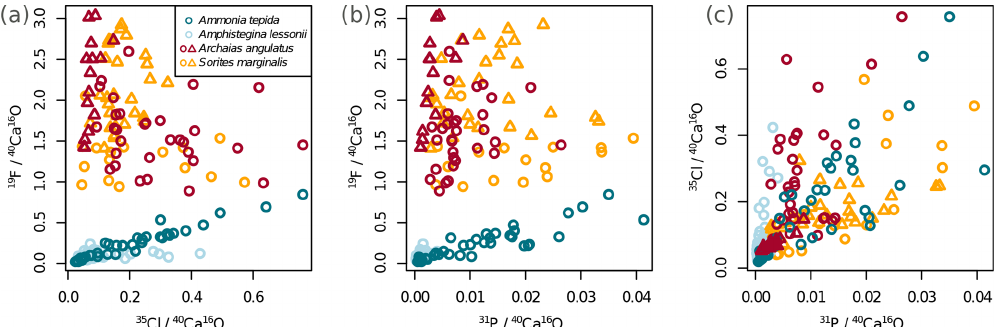
Figure 2. Variability of the different El / Ca ratios within shells of the studied foraminifera. Individual data points represent multiple regions of interest (ROIs) drawn on the images as described in Sect. 2.4. Values are shown as ratios of secondary ion counts measured by NanoSIMS. Symbol shapes that are the same colour depict different specimens of the same